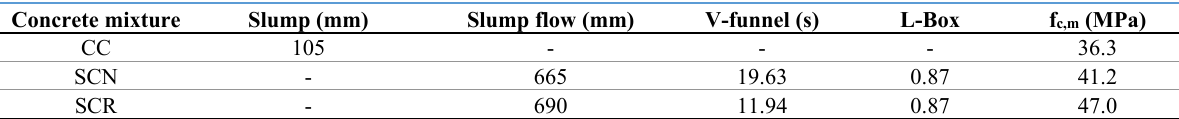
Table 2. Fresh and hardened properties of self-consolidating and conventional vibrated